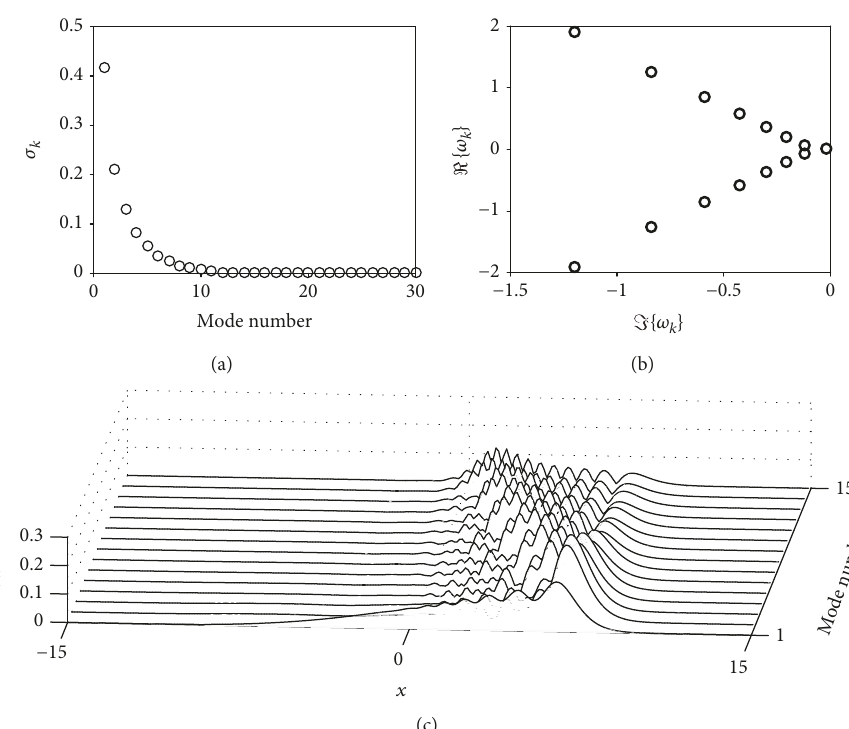
Figure 3: DMD of the Burgers ’ equation. (a) The singular value spectrum demonstrates that a rank r = 15 truncation should be adequate to capture the dynamics of the front propagation in Figure 2. (b) The eigendecomposition in the DMD algorithm produces a DMD spectra whose eigenvalues are decaying. (c) The DMD modes used for reconstructing the solution in Figure 2 ordered according the smallest to largest (in magnitude) eigenvalues. The fi rst mode is like a background mode since the eigenvalue is almost